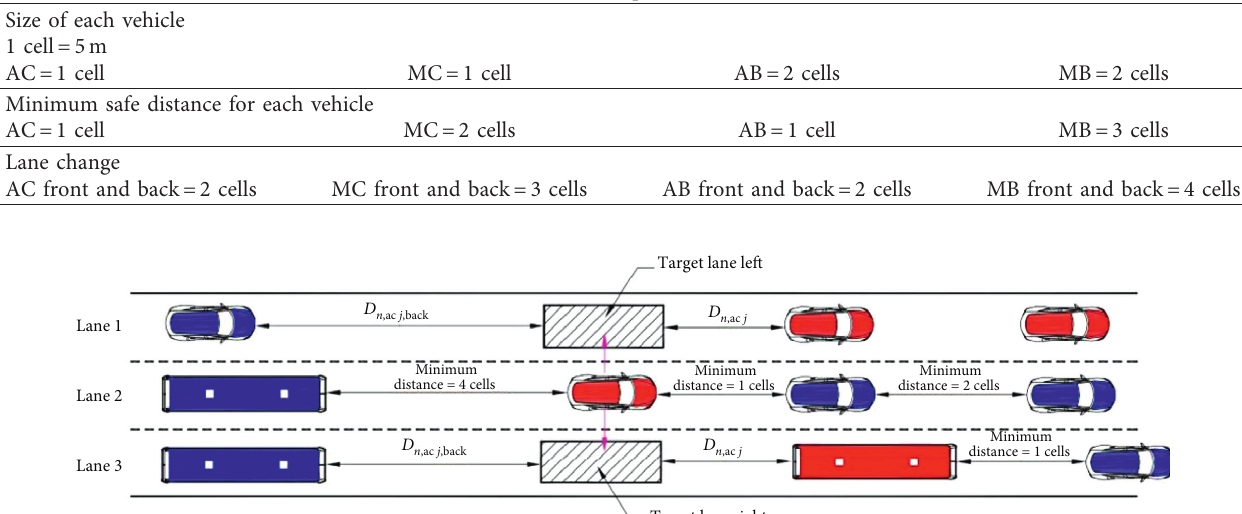
Table 4: Fundamental parameters of model.